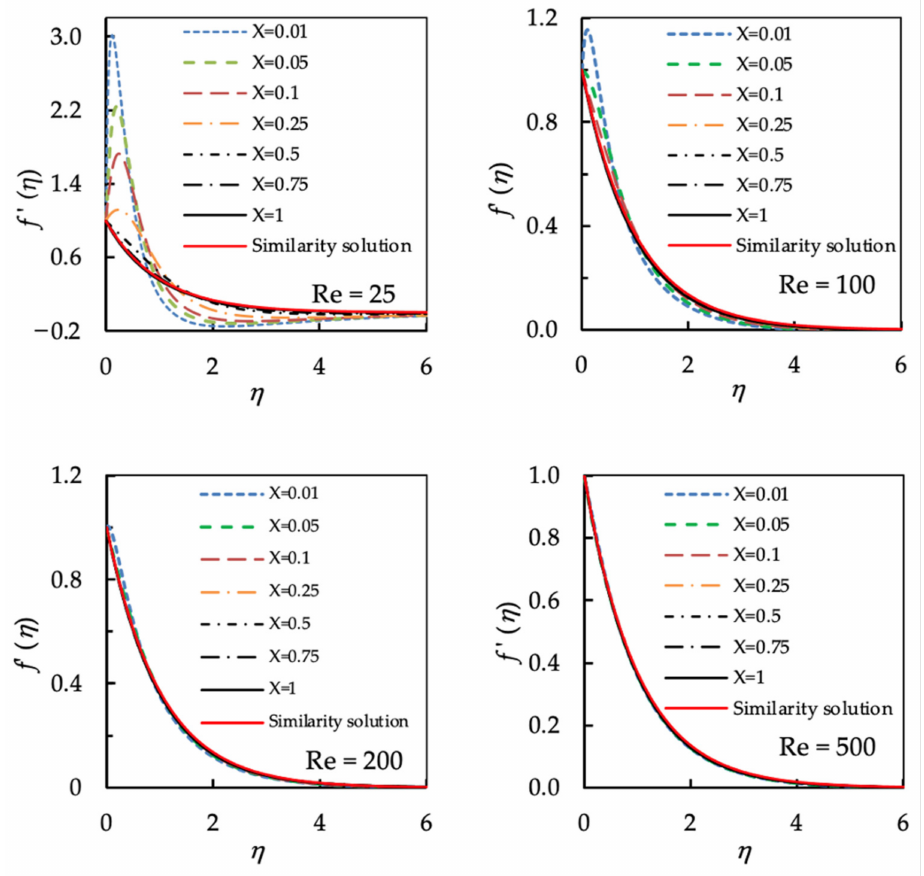
Figure 3. Effect of the Reynolds number, Re , on the velocity distribution at different positions along the sheet ( X values) for Gr = 10 4 , Pr = 6.2, Le = 10, Nb = Nt = Nr = Rb = Ω = 0.1, and Pe = Lb =